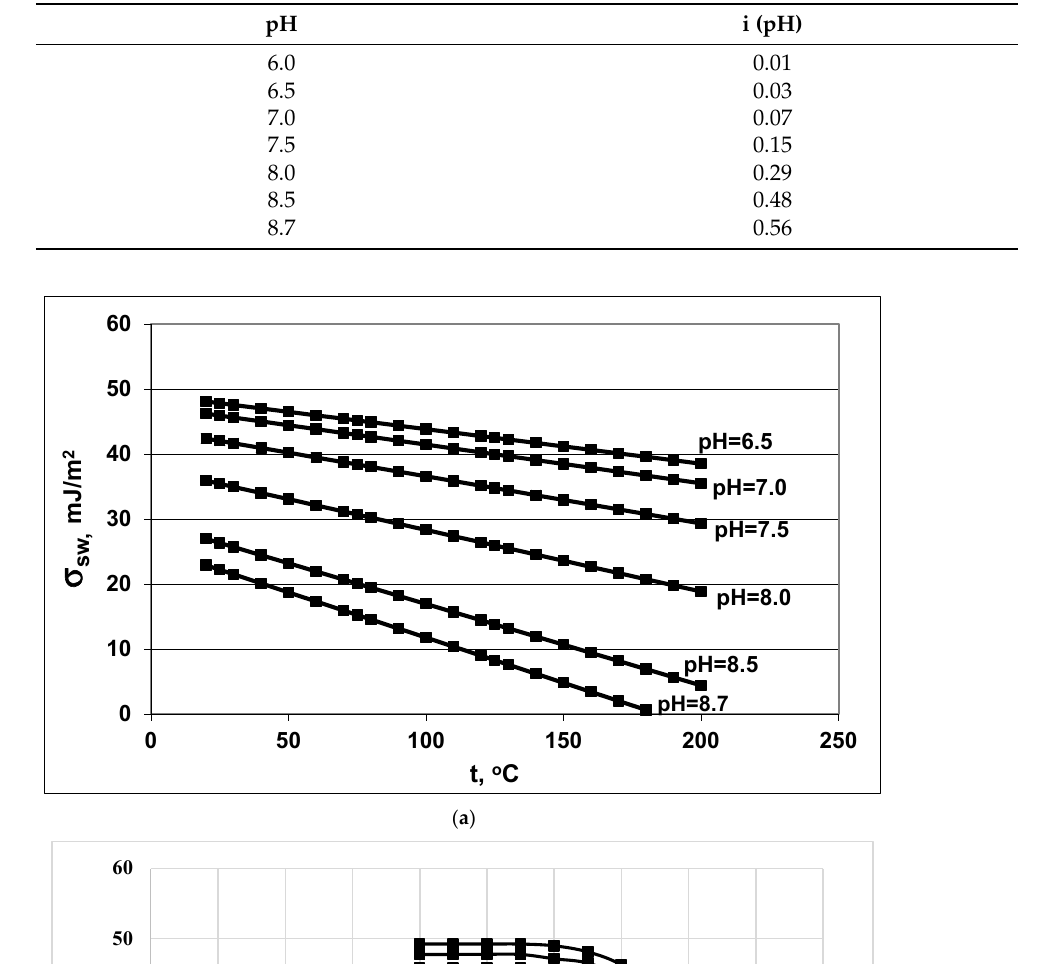
Commented [M45]: No explanation of sub figure a,b. Please provide in the caption. Commented [M46]: We changed this from "equation (1.9)" to "Equation (9)", please confirm.